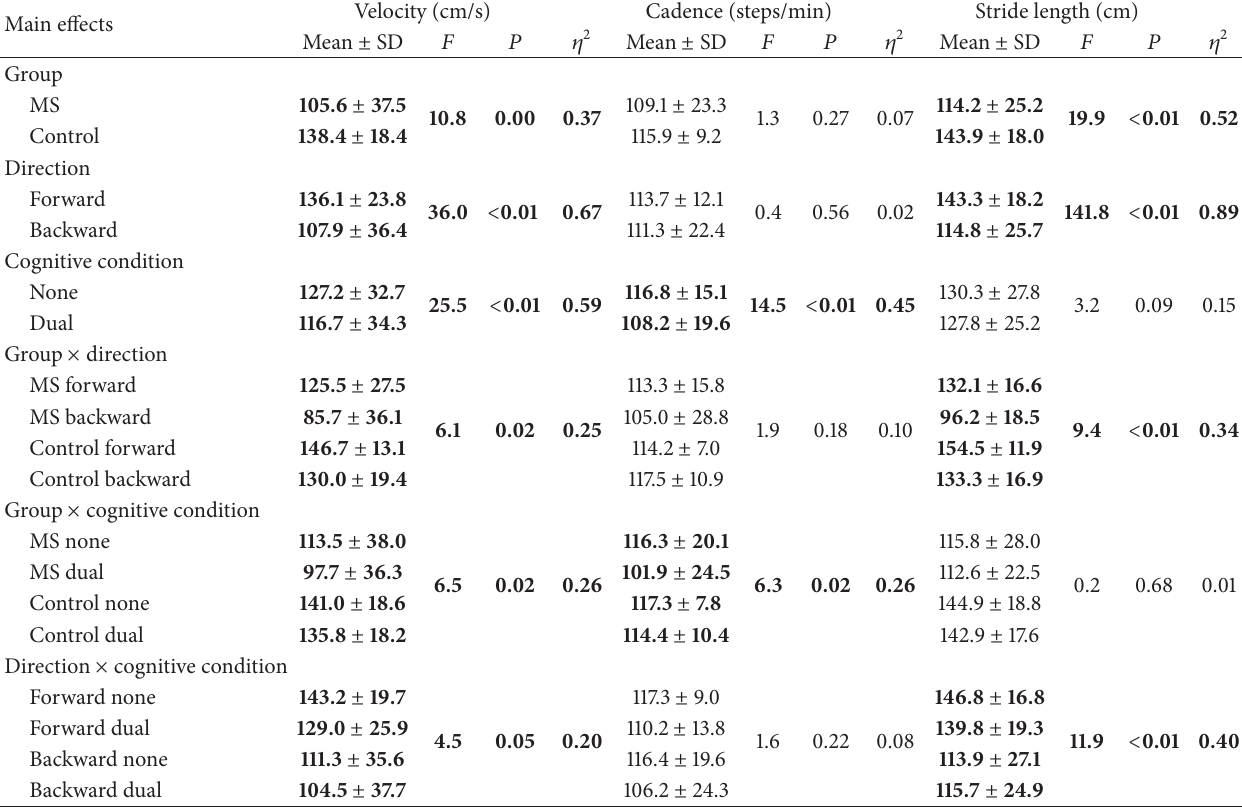
Table 1: Main effects and two-way interactions for spatiotemporal gait